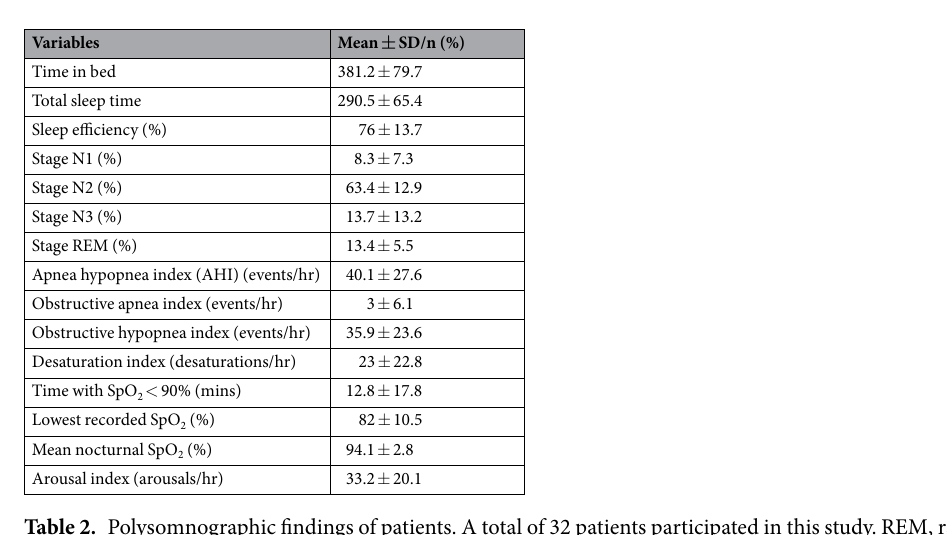
Table 2. Polysomnographic findings of patients. A total of 32 patients participated in this study. REM, rapid eye movement; NREM,